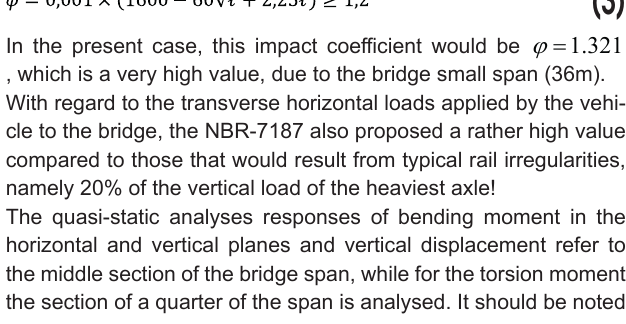
Low-hierarchy model of the bridge (‘unifilar’